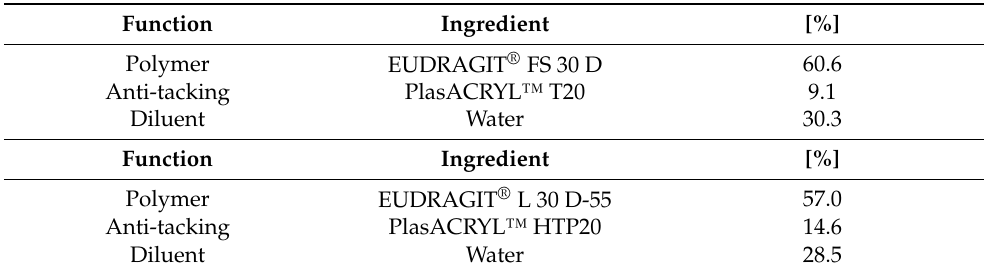
Table 1. EUDRAGIT ® polymer